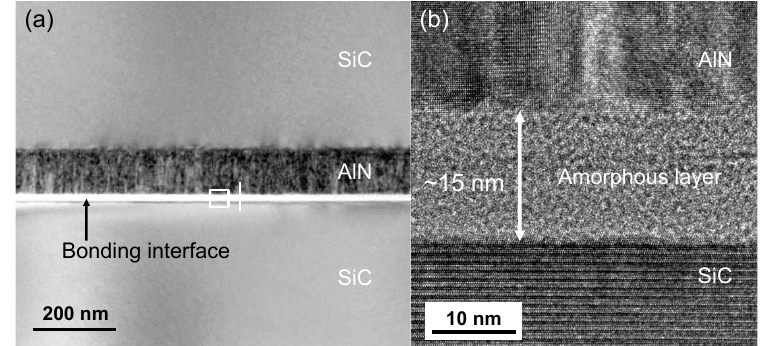
Figure 4. ( a ) Scanning transmission electron microscopy (STEM) image of the bonded SiC-AlN interface at a low magnification and ( b ) the magnification of the rectangular area in ( a ).